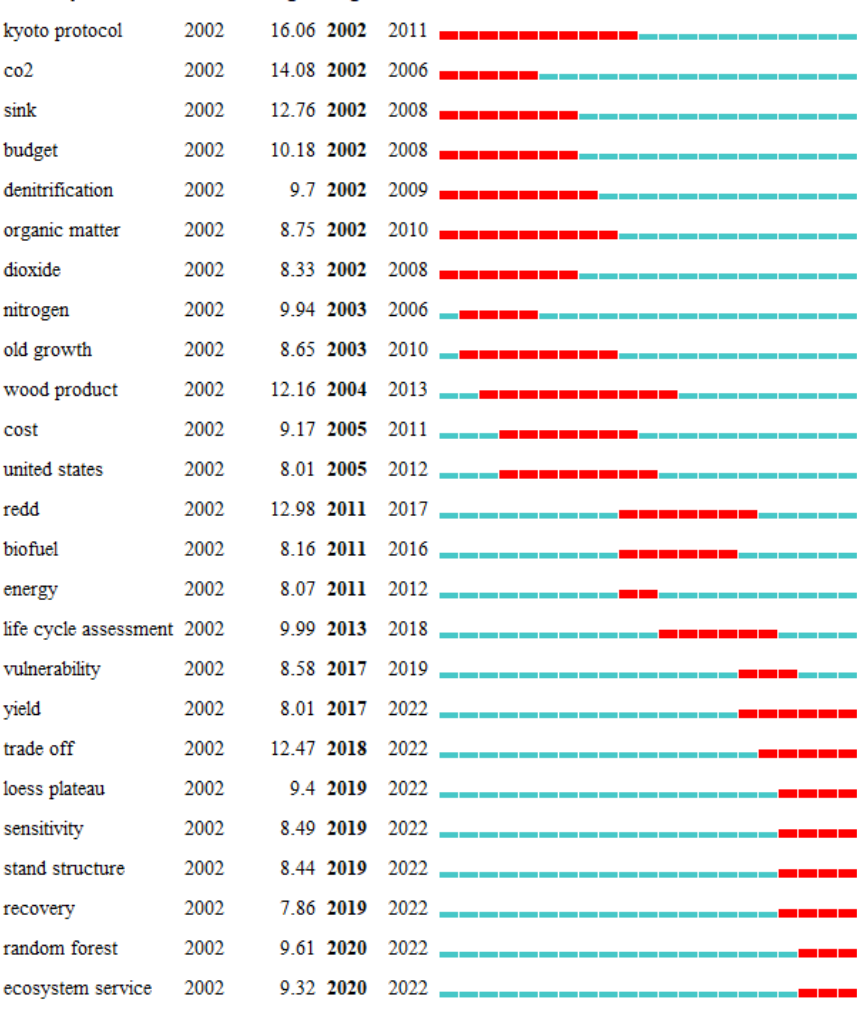
Figure 13. Top 25 keywords with the strongest citation bursts.